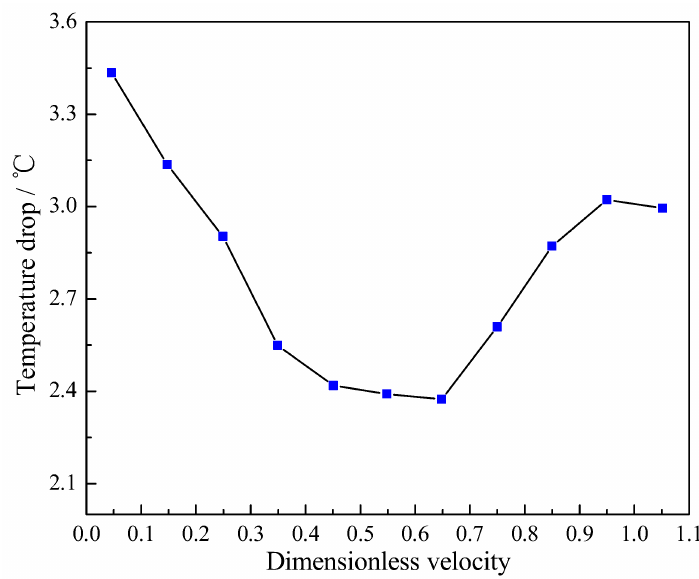
Figure 14. Water temperature decline from experiment versus dimensionless